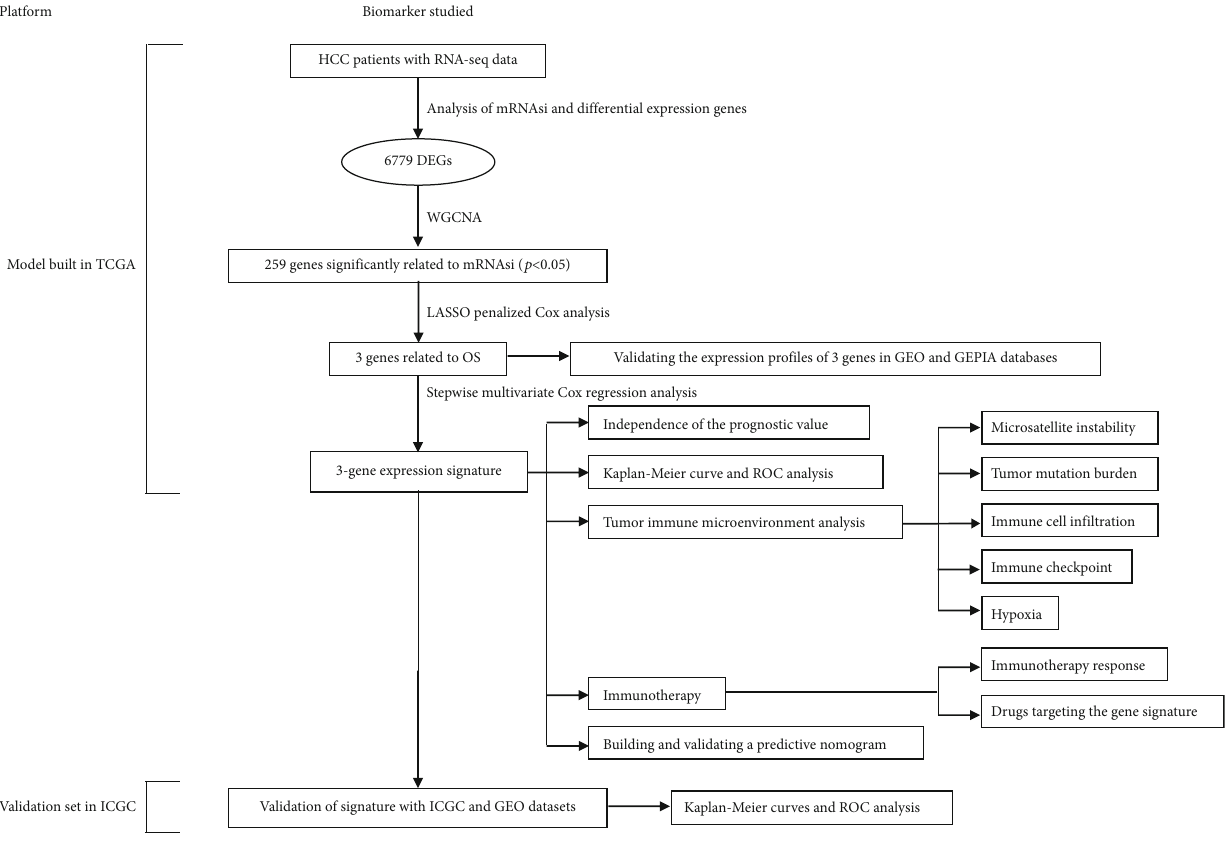
Figure 1: Overall fl owchart of this